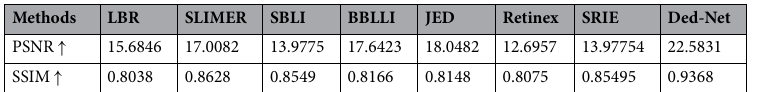
Table 1. Comparison of PSNR and SSIM metrics with several methods.